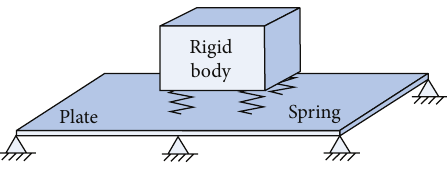
Figure 1: Vibration isolation